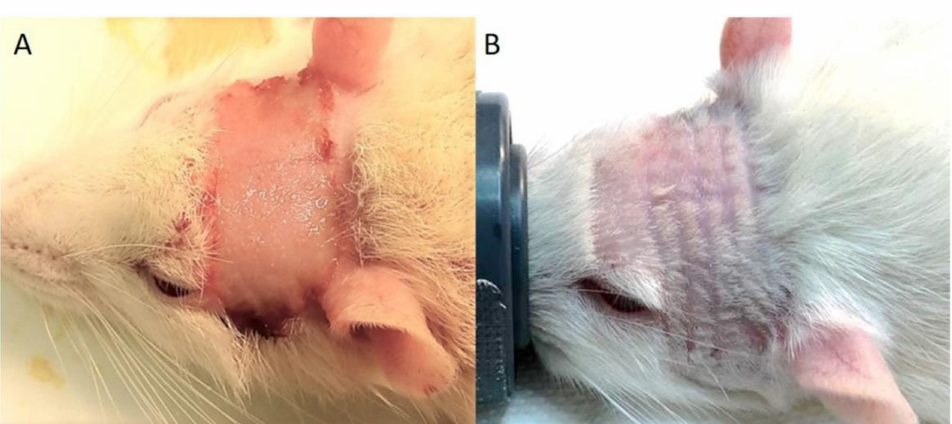
Figure 2. Radiation-induced skin toxicities after irradiation. ( A ) Rats receiving 30 Gy conventional broad beam irradiation developed severe cutaneous ulceration (radiation dermatitis) 11 to 12 days after irradiation. ( B ) Rats receiving crossfire pMBRT (in one or two fractions, 15 Gy or 20 Gy per array) did not show macroscopic signs of skin ulceration/radiation dermatitis. Nevertheless, they exhibited transient radiation-induced alopecia in the path of the beams, starting between 11 and 18 days after the last